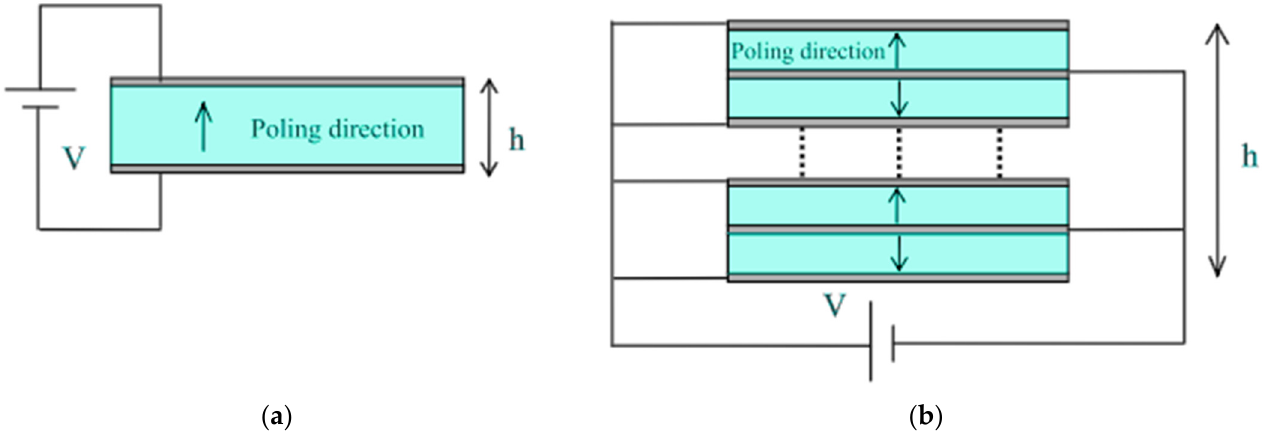
Figure 3. Piezoelectric patches: ( a ) single-layer patch and ( b ) multi-layer patch. Reprinted from [6], Copyright 2021, with permission from Elsevier.